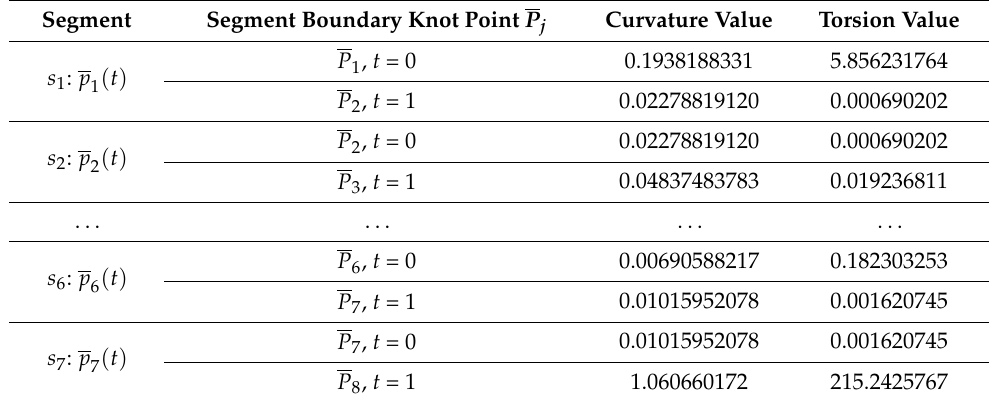
Table 2. Curvature and torsion values at boundary points of the